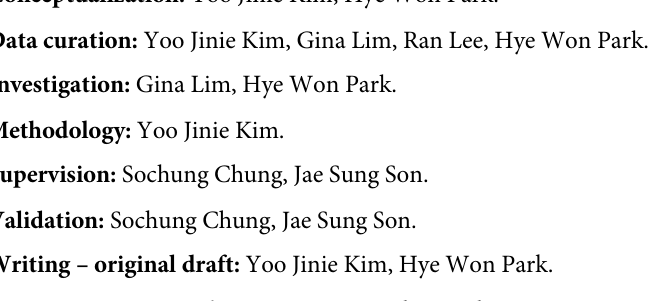
S1 Table. PRISMA checklist. S2 Table. The quality assessment of included study using the Newcastle-Ottawa Scale. S1 Fig. Sensitivity analysis (1–1), and cumulative analysis (1–2) for the relationship between vitamin D deficiency defined using a cut off value of 30 ng/ml and RDS. S2 Fig. Sensitivity analysis (2–1), cumulative analysis (2–2), and funnel plot (2–3) for the relationship between vitamin D deficiency defined using a cut off value of 20 ng/ml and RDS. S3 Fig. Sensitivity analysis (3–1), cumulative analysis (3–2), and funnel plot (3–3) for the relationship between vitamin D deficiency defined using a cut off value of 10 ng/ml and RDS. S4 Fig. Sensitivity analysis (4–1), cumulative analysis (4–2), and funnel plot (4–3) for the relationship between vitamin D level and